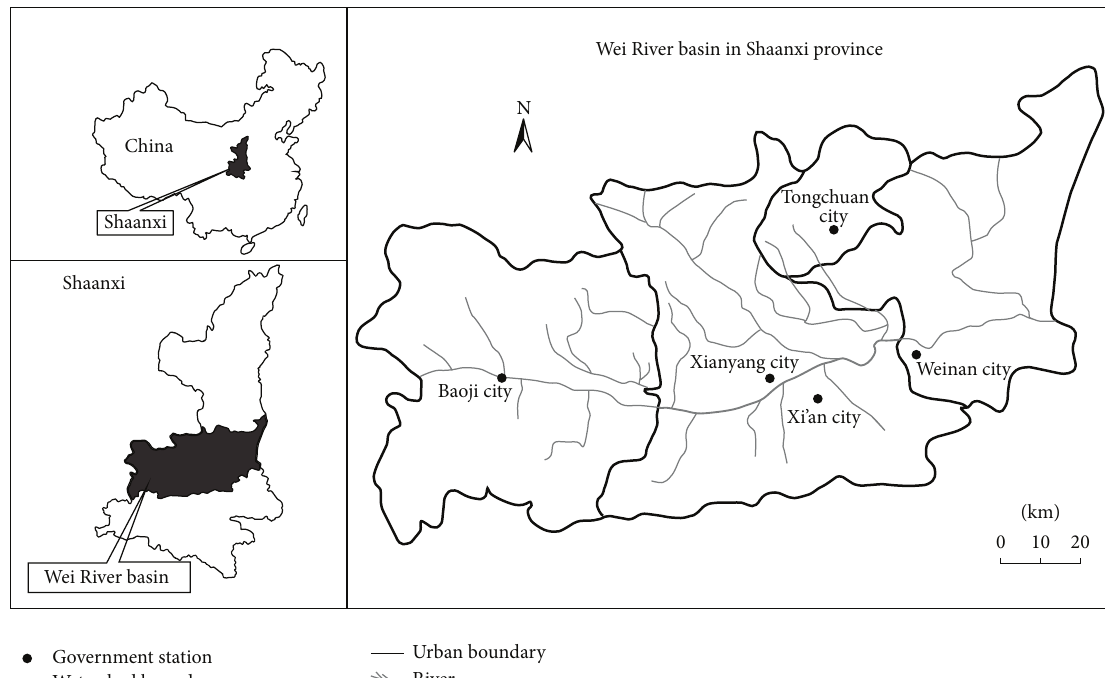
Figure 1: Map of the Wei River basin in Shaanxi province,